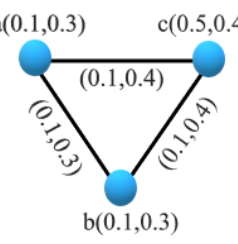
Figure 3. Intuitionistic fuzzy graph.